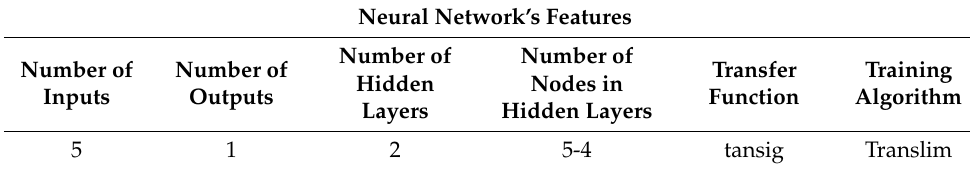
Table 7. Neural network characteristics as the best model.